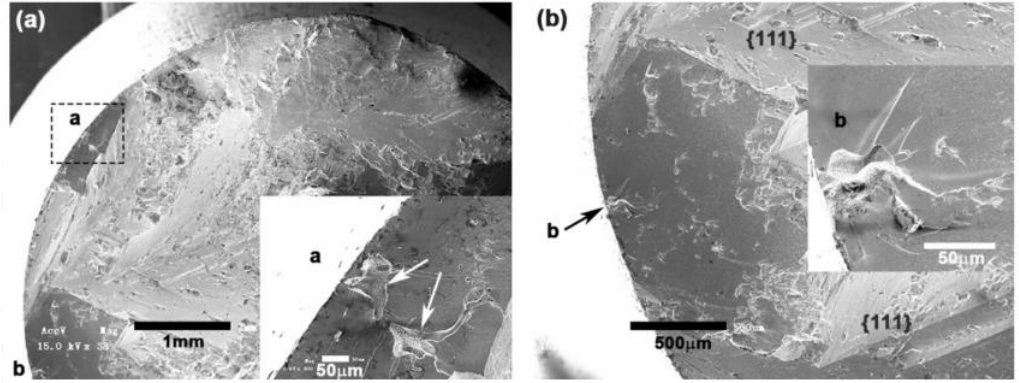
Figure 5. Original single crystal superalloy exhibited crystallographic fracture mode at 550 ◦ C ( ε n = 0.6%, N f = 15855 cycles): ( a ) overall fracture surface; ( b ) crack initiation at casting